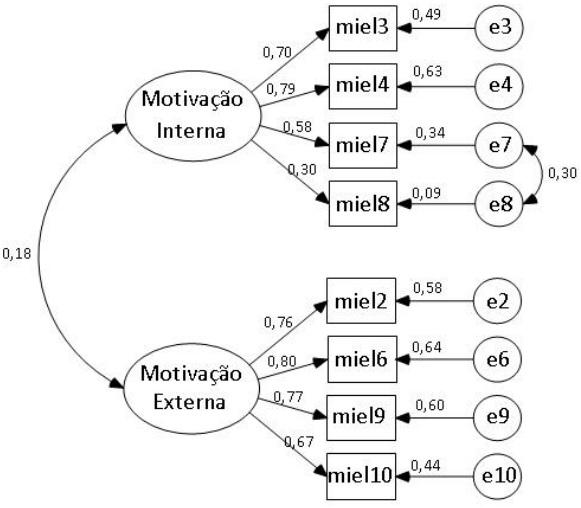
Figura 2 . Estrutura fatorial da Escala de Motivações Externa e Interna para Responder sem Preconceito frente a Lésbicas